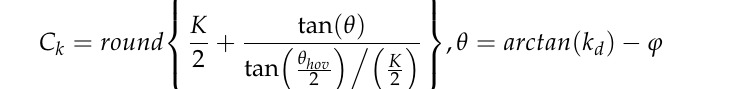
Taking the plane of the diffuser as the reference plane in the SPOC algorithm, we mark the intersection point of the display ray and the reference plane as S , where S coincides with P n . The nearest camera ( C ) is used to capture S to approximate the capture of P n by C ideal , which is combined with the FOV of the capture camera ( θ hov ) to determine pixel C k by Equation (4) corresponding to the capture ray between C and S ( l CS ) on the imaging plane ( I ):